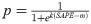
Plot of state-action prediction error, simulated LC spiking and behaviour during 100 trials of the go/no-go task, (for agents with a fixed value of model decay parameter α not linked to state-action prediction error).Each point within the task is assumed to last 1s and is associated with a single state-action prediction error. In (a) the raw prediction error is extracted for t = 2, when the animal receives a cue (this is the error between t = 1 and t = 2) and t = 3 when the animal receives feedback on its response to the cue (the error between t = 2 and t = 3). Because the prediction error explicitly evaluates differences between update cycles, there is no error available for the first time point. Each trial has therefore been collapsed to two time points, each lasting 1 second. In (a) the occurrence of the ‘go’ cue causes strong peaks in prediction error. This is converted into a simulated LC firing rate in (b). To visualise LC firing, a firing probability p is calculated for each second using the state-action prediction error (SAPE) as the input into a logistic function, so that p=11+ek(SAPE−m) where k = 8, and m is as above. Each second was then further split into 0.1s bins, during which the unit generated a single spike with probability p. This gives a physiologically reasonable [1,22,23] maximum firing rate of 10hz if p = 1. This is converted into a simulated LC firing rate in (b), showing phasic LC activation when the ‘go’ cue is heard. Plot (c) is a graphical representation of behaviour during the task at times t = 2 and t = 3 for each trial, in which the position of the coloured block describes the agent’s location and the colour shows the agent’s observation after moving.